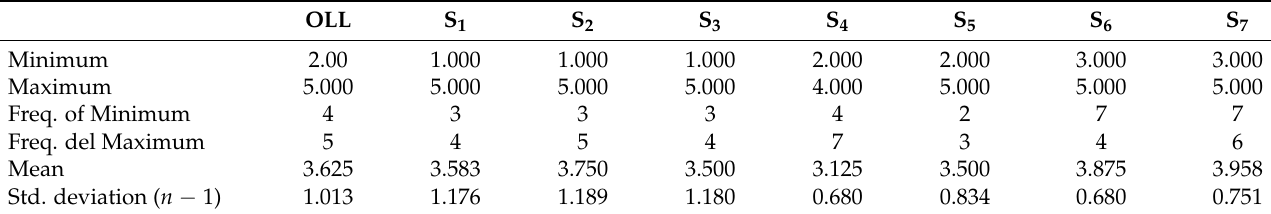
Table 10. Teacher evaluation of criteria: statistical results.